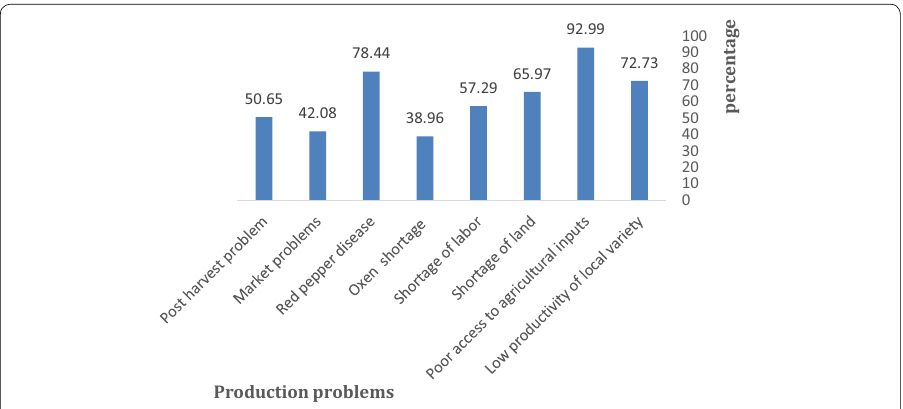
Fig. 3 Production problems faced by pepper producers. *Multiple